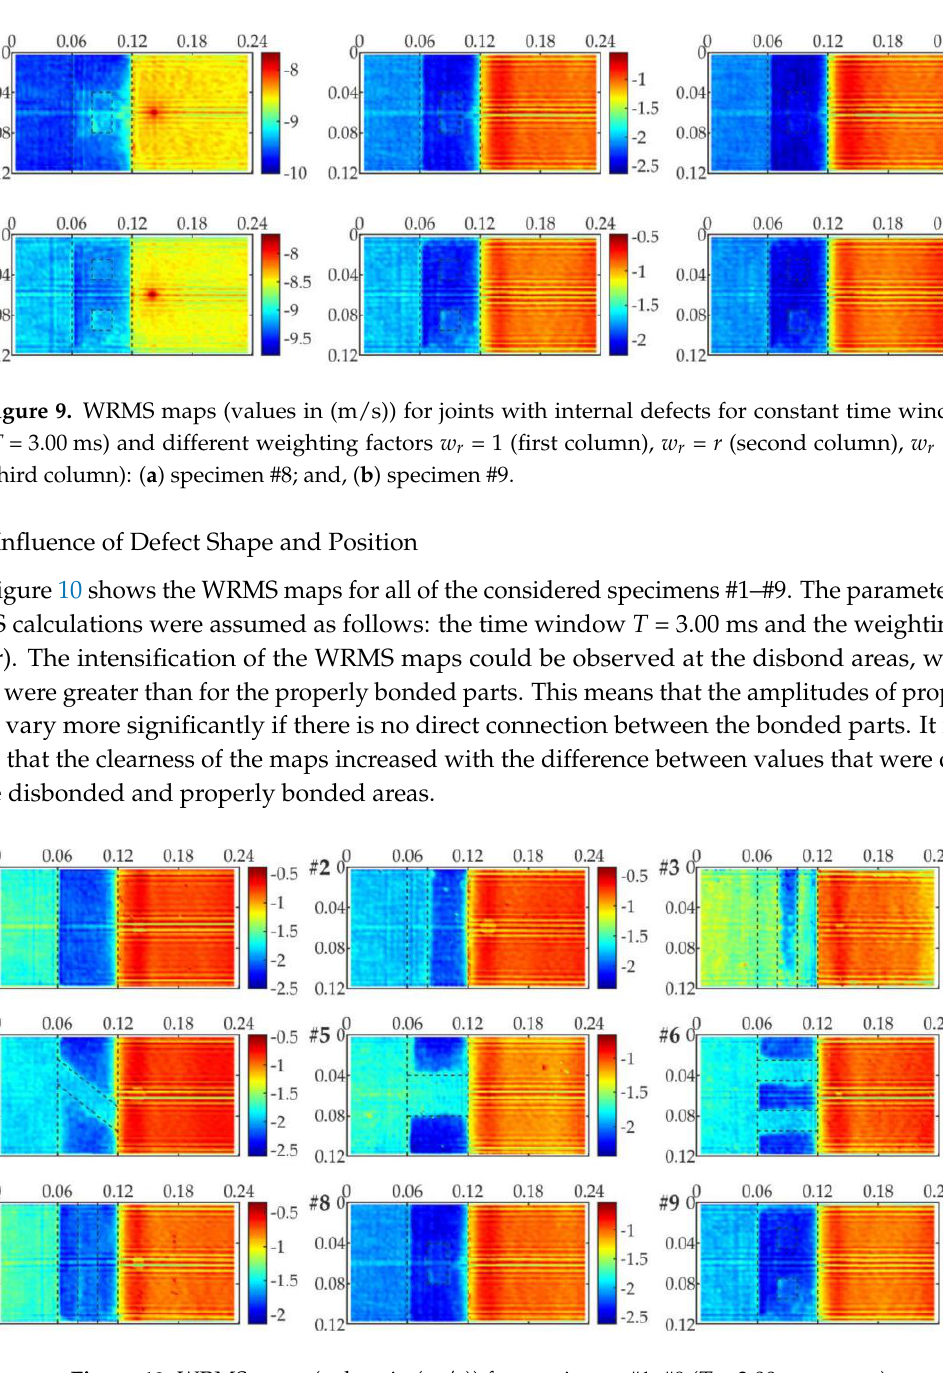
Figure 10. WRMS maps (values in (m/s)) for specimens #1–#9 ( T = 3.00 ms, w r = r